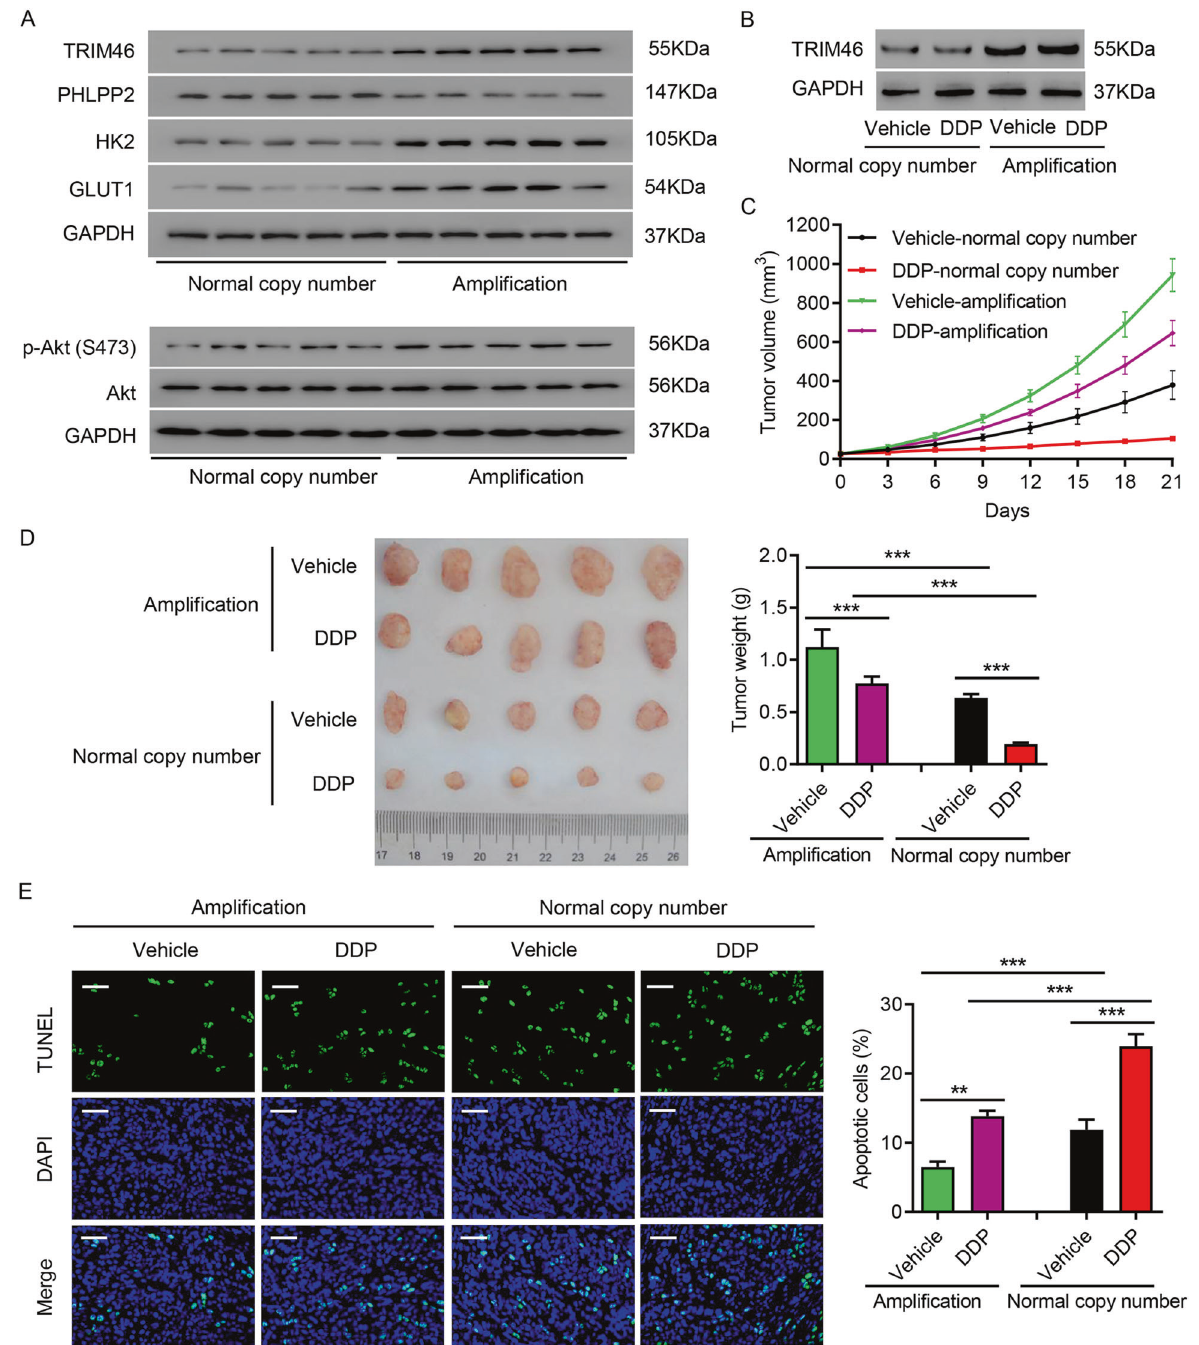
Fig. 7 Ampli fi cation of TRIM46 promoted PDX growth and enhanced DDP resistance. A Expression of PHLPP2, TRIM46, p-AKT (Ser473), HK2, and GLUT1 in LUAD tissues with/without TRIM46 ampli fi cation. B – E LUAD tissues with/without TRIM46 ampli fi cation were used to create a PDX model and at seven days after inoculation, DDP (5 mg/kg/d) was administered to tumor-bearing mice by intraperitoneal injection for 3 weeks. B Expression of TRIM46 in PDX model with/without TRIM46 ampli fi cation. C Tumor volume of PDX model. D Tumor weight. E TUNEL staining results (Scale bar: 50 μ m). Results were presented as the mean ± standard error ( n = 5). Independent experiments were repeated three times. ** P < 0.01, *** P < 0.001.